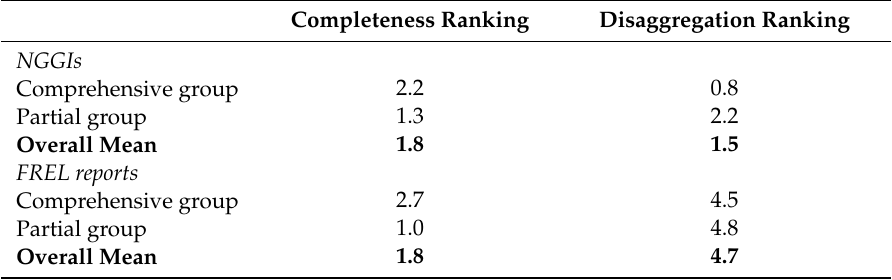
Table 8. Mean completeness and disaggregation rankings for the National Greenhouse Gas